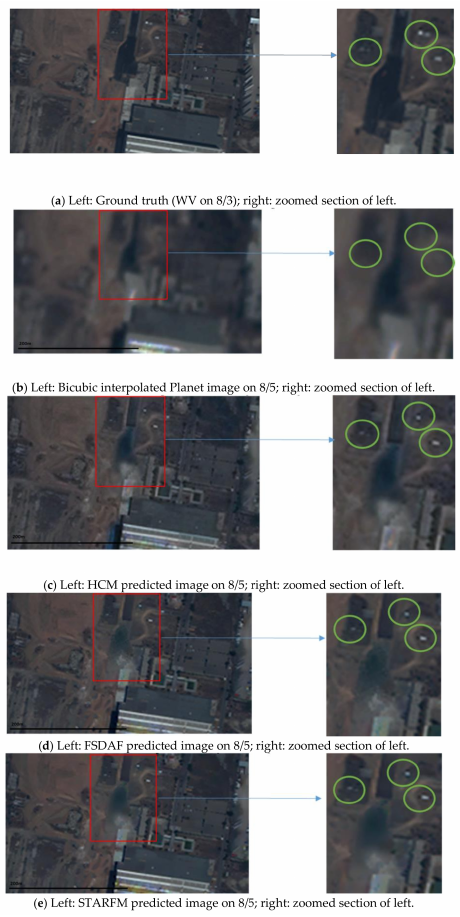
Figure 6. Comparison of different fused images with the ground truth (WV) and the low resolution Planet image at the prediction time. Canal